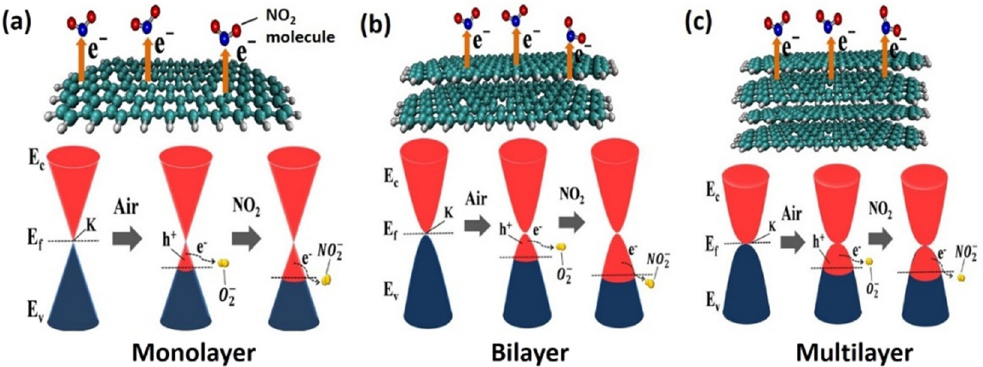
Figure 12: Schematic diagram of band diagrams of NO 2 - sensing mechanism of ( a ) monolayer, ( b ) bilayer, and ( c ) multilayer of graphene gas sensors proposed by Seekaew et al. Reproduced from ref. [ 107 ]